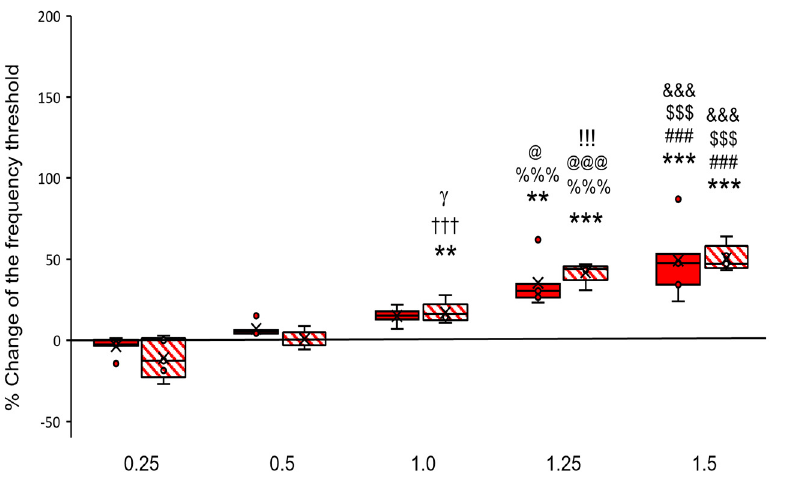
Figure 1. Percent change of the frequency threshold in the feeding response (FR) during unilateral electrical VTA stimulation (Es ‐ VTA) directly after morphine injection at different doses (0.25 μ g/0.5 μ L, 0.5 μ g/0.5 μ L, 1.0 μ g/0.5 μ L, 1.25 μ g/0.5 μ L, or 1.5 μ g/0.5 μ L) into the PPN in the contralateral (used for each dose n = 5) (red ‐ filled bars) and ipsilateral hemisphere (used for each dose n = 5) (red ‐ hatched bars) compared to artificial cerebrospinal fluid (ACSF; a value of 0.0% on the y ‐ axis) injected in the PPN as baseline control. Tukey’s post hoc test: ** p < 0.01, *** p < 0.00 directly above the bars indicate a significant difference from experimental groups with different injection doses (1.0, 1.25, and 1.5 μ g) compared to baseline (Mc, Mi groups vs. baseline); ### p < 0.001 indicate a significant difference from morphine injection doses (dose 1.5 μ g vs. dose 0.25 μ g) in the experimental groups (Mc, Mi groups); $$$ p < 0.001 indicate a significant difference from morphine injection doses (dose 1.5 μ g vs. dose 0.5 μ g) in the experimental groups (Mc, Mi groups); &&& p < 0.001 indicate a significant difference from morphine injection doses (dose 1.5 μ g vs. dose 1.0 μ g) in the experimental groups (Mc, Mi groups); %%% p < 0.001 indicate a significant difference from morphine injection doses (dose 1.25 μ g vs. dose 0.25 μ g) in the experimental groups (Mc, Mi groups); @ p < 0.05, @@@ p < 0.001 indicates a significant difference from morphine injection doses (dose 1.25 μ g vs. dose 0.5 μ g) in the experi ‐ mental groups (Mc, Mi groups); !!! p < 0.001 indicate a significant difference from morphine injection doses (dose 1.25 μ g vs. dose 1.0 μ g) in the experimental group (Mi groups); ††† p < 0.001 indicate a significant difference from morphine injection doses (dose 1.0 μ g vs. dose 0.25 μ g) in the experi ‐ mental group (Mi group); γ p < 0.05 indicate a significant difference from morphine injection doses (dose 1.0 μ g vs. dose 0.5 μ g) in the experimental group (Mi group).